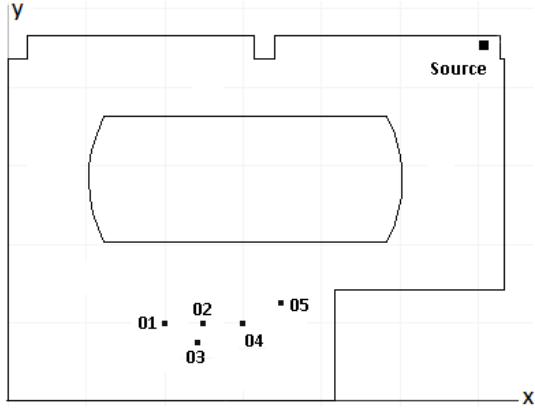
Figure 19. Listener positions selected to evaluate the auralization system.